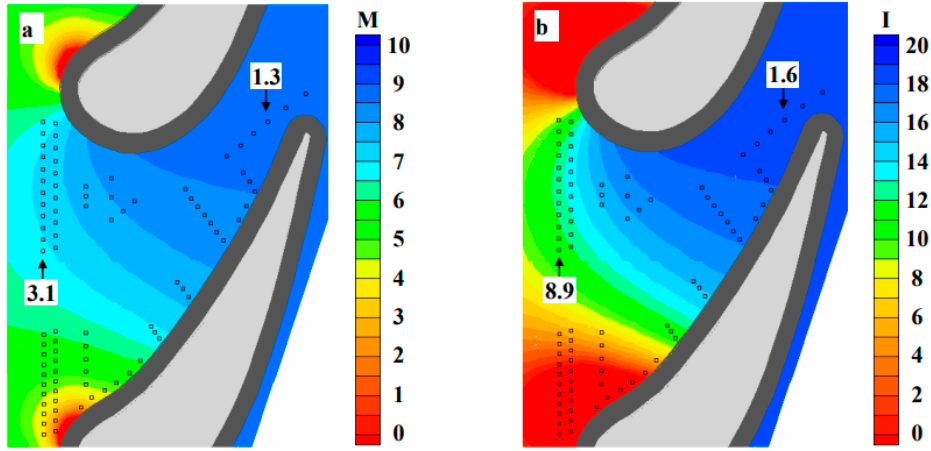
Figure 13. Blowing ratio and momentum flux ratios can be different for the same film configuration as shown by [78]. Film effectiveness comparison of low and high momentum flux ratio (I) and comparative effect by density ratios (DR) were shown by [79,80].